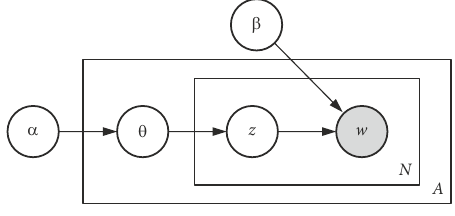
Figure 2. Graphical model for LDA Figure 3. Graphical model for